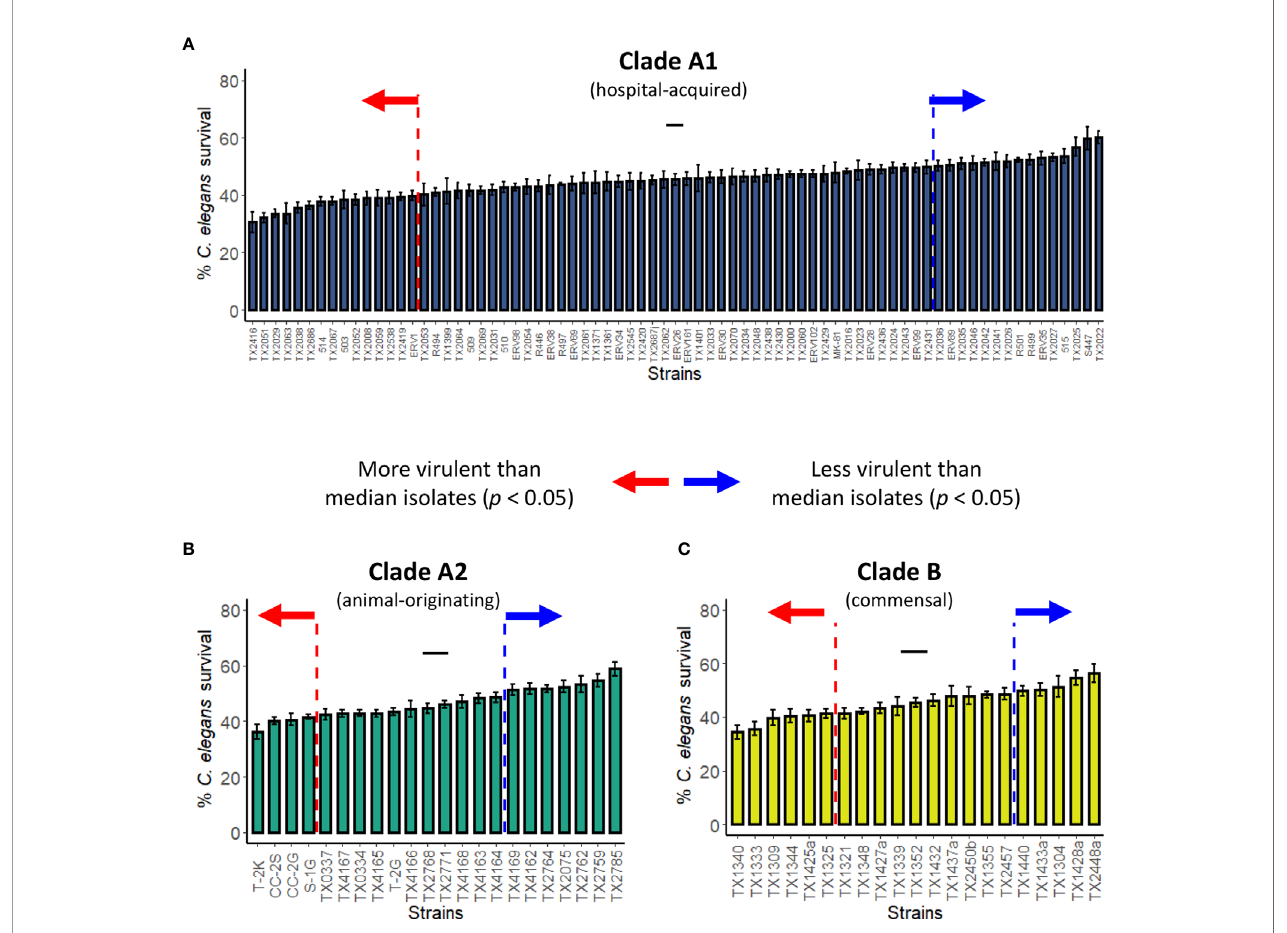
FIGURE 4 | Pathogenicity distribution of E. faecium strains belonging to Clade A1, A2, or B C. elegans were exposed to E. faecium strains belonging to (A) Clade A1, (B) Clade A2, or (C) Clade B in the liquid-killing assay. At least three biological replicates with ~80 worms/replicate were analyzed. Error bars represent SEM. p values were determined from Student ’ s t -test against the median isolates (indicated with short black lines in the graphs). Arrows indicate all isolates that are more (red) or less (blue) virulent than the median isolates ( p <